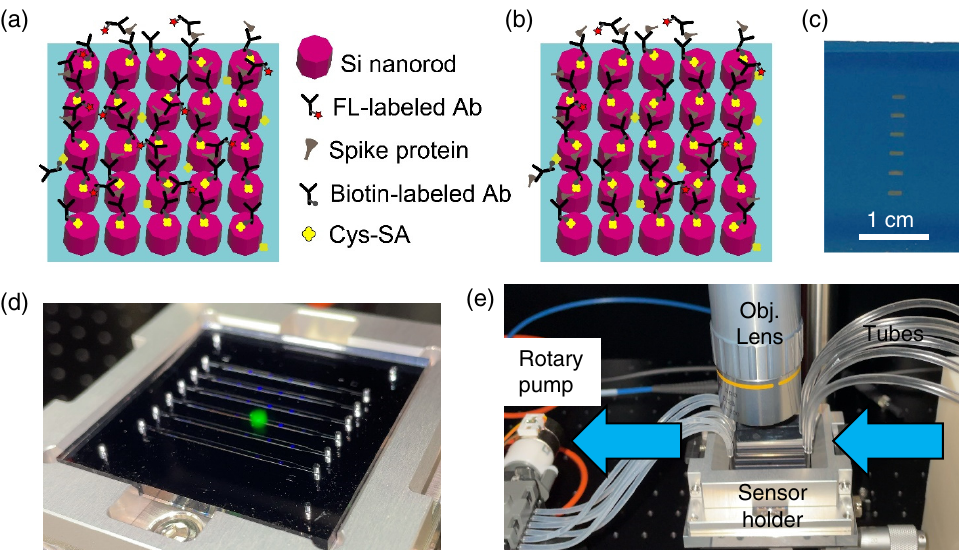
Figure 1. Schematics and overview of this study. Illustrations for detection of ( a ) glycoproteins and ( b ) antibodies (Abs) on the all-dielectric metasufaces of the Si nanorod array, which is located on the SiO 2 layer (pale blue). Si nanorods, labeled Abs, spike protein, and Cys-SA are listed. ( c ) Photograph of an all-dielectric metasurface substrate. Six metasurface areas are vertically arrayed. The white scale bar indicates 1 cm. ( d ) Metasurface sensor chip, composed of a self-absorbed pair of an on-top PDMS microfluidic chip with six channels and a metasurface substrate of 45 × 45 mm 2 . The chip is set in a holder. ( e ) Actual view of experimental setup around a metasurface sensor chip in the holder. The metasurface sensor chip is connected through tubes. The arrows indicate the direction of liquid flow. The objective lens facilitates access from the top to conduct FL measurement on the metasurface